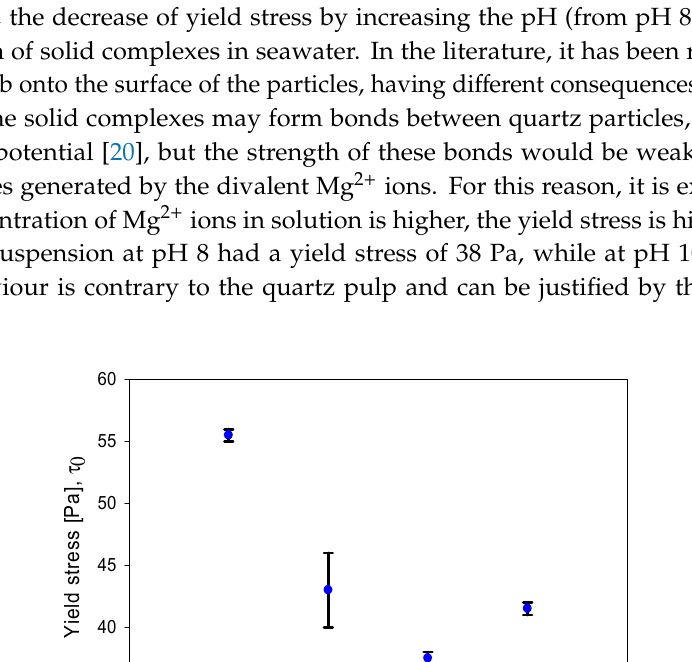
Figure 6. Creep test for quartz and kaolin slurries at varied applied stresses: ( a ) quartz at pH 8, ( b ) quartz at pH 10.7, ( c ) kaolin at pH 8 and ( d ) kaolin at pH 10.7.